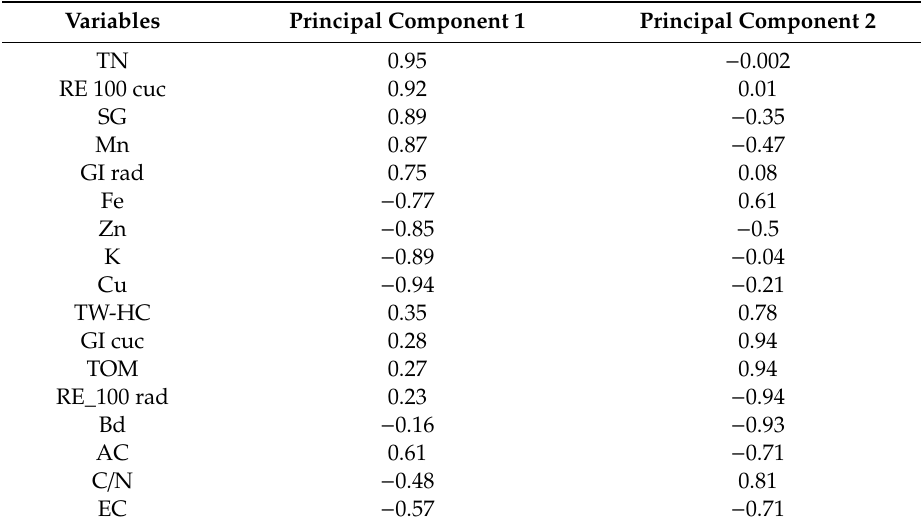
Table 3. Correlations with the original variables of the PCA